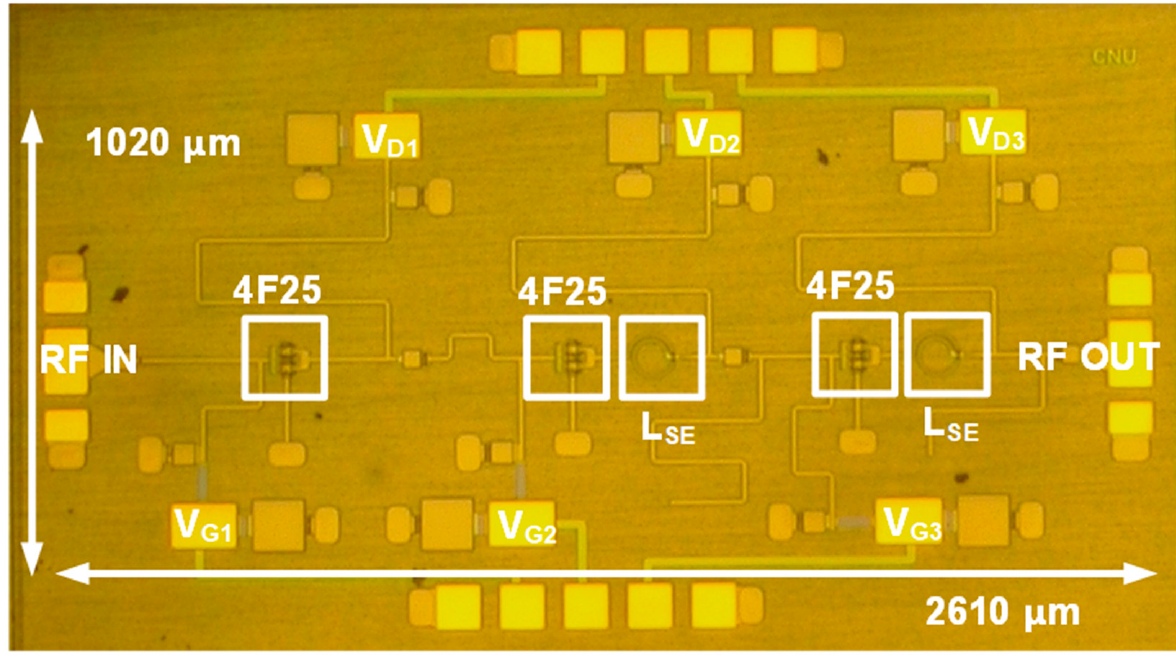
Figure 8. Die microphotograph of the implemented GaN HEMT ‐ based low ‐ noise amplifier.